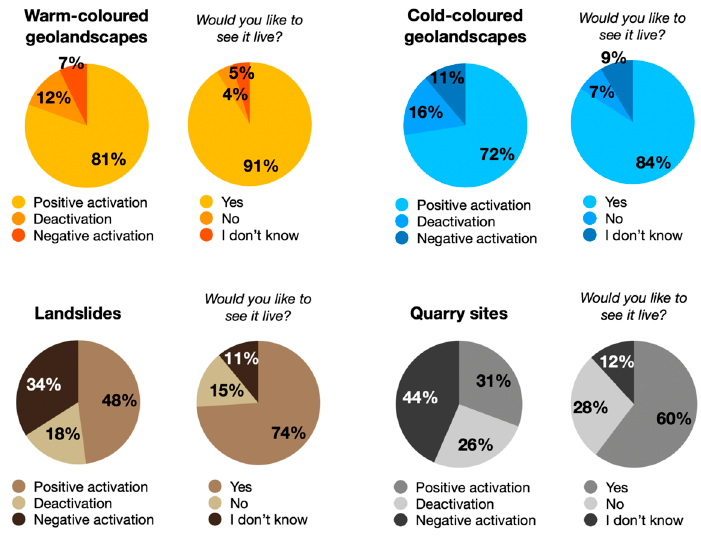
Figure 7. Quarry sites landscapes of Paesaggeo online survey: ( A ) San Giovanni in Galilea quarry; ( B ) Mt. Ceti quarry.